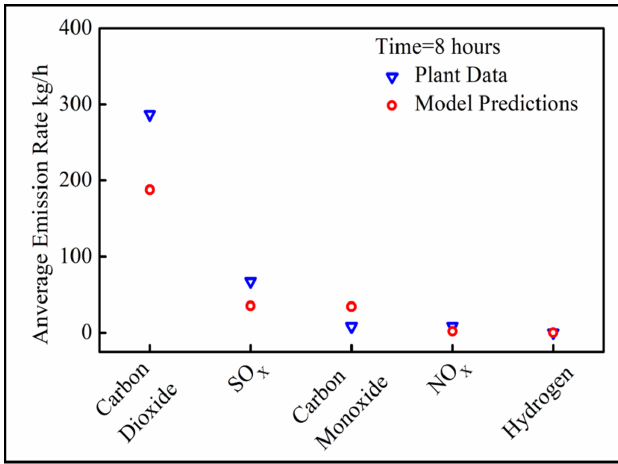
Figure 8. Verification of the model.